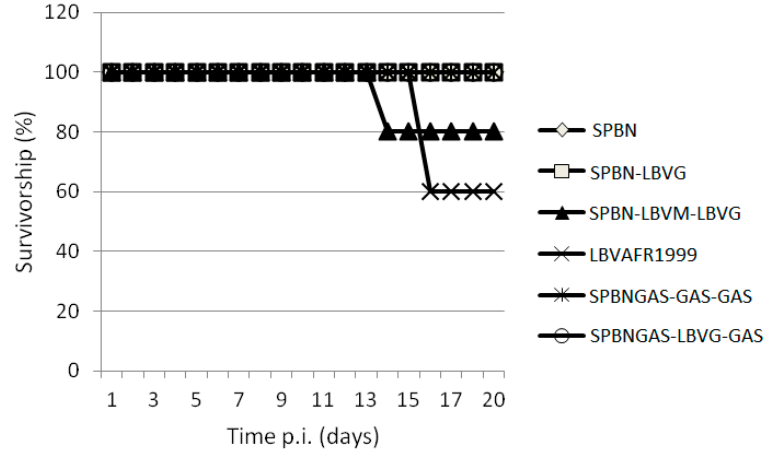
Figure 4. Pathogenicity of SPBN, SPBN-LBVG, SPBN-LBVM-LBVG, LBVAFR1999, SPBNGAS-GAS-GAS and SPBNGAS-LBVG-GAS in mice. Groups of 5 (Crl:CD1 [ICR]) mice were inoculated via the i.m. route with 5 × 10 6 TCID 50 /50 µ L of virus. The experiment was terminated after 43 days, but no clinical signs were observed 16 days post infection.